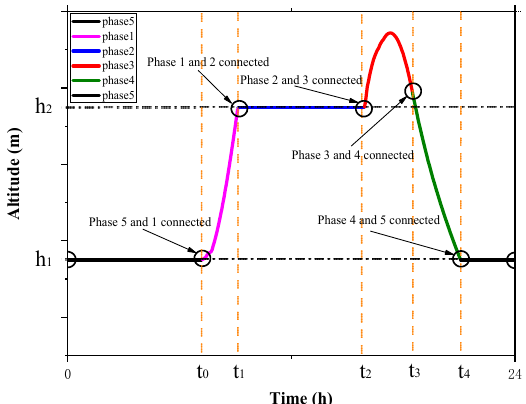
Figure 4. Schematic diagram of connection for multi-phase optimization problems.